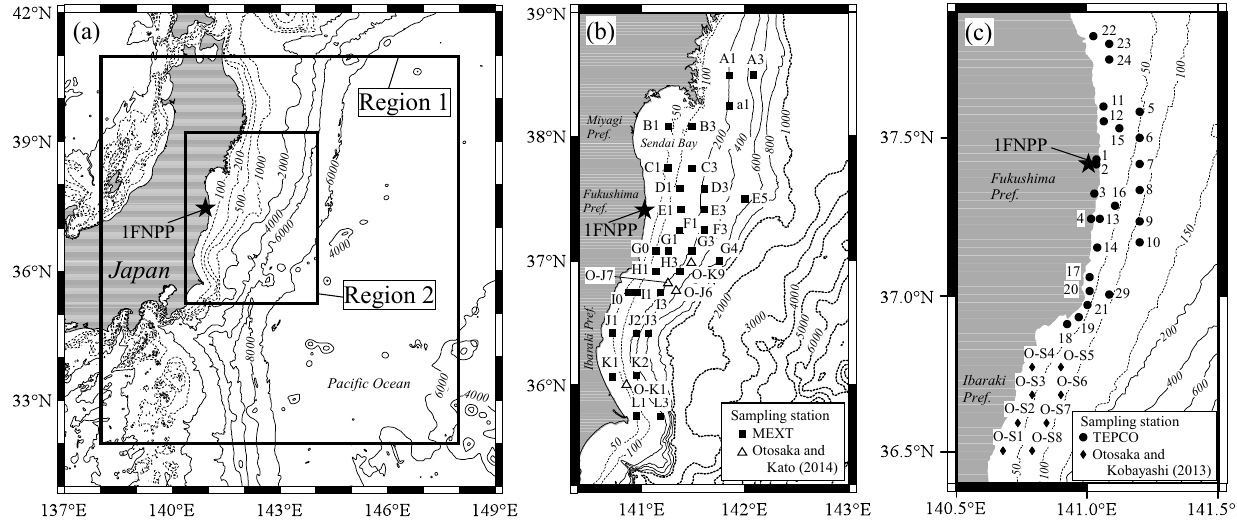
Figure 2. (a) Simulation domain (Region-1 and -2) and locations of sampling stations in (b) MEXT (2011) and Otosaka and Kato (2014) and (c) TEPCO (2011) and Otosaka and Kobayashi (2013). Black star indicates location of 1FNPP. Contours show water depth (m) according to JTOPO30